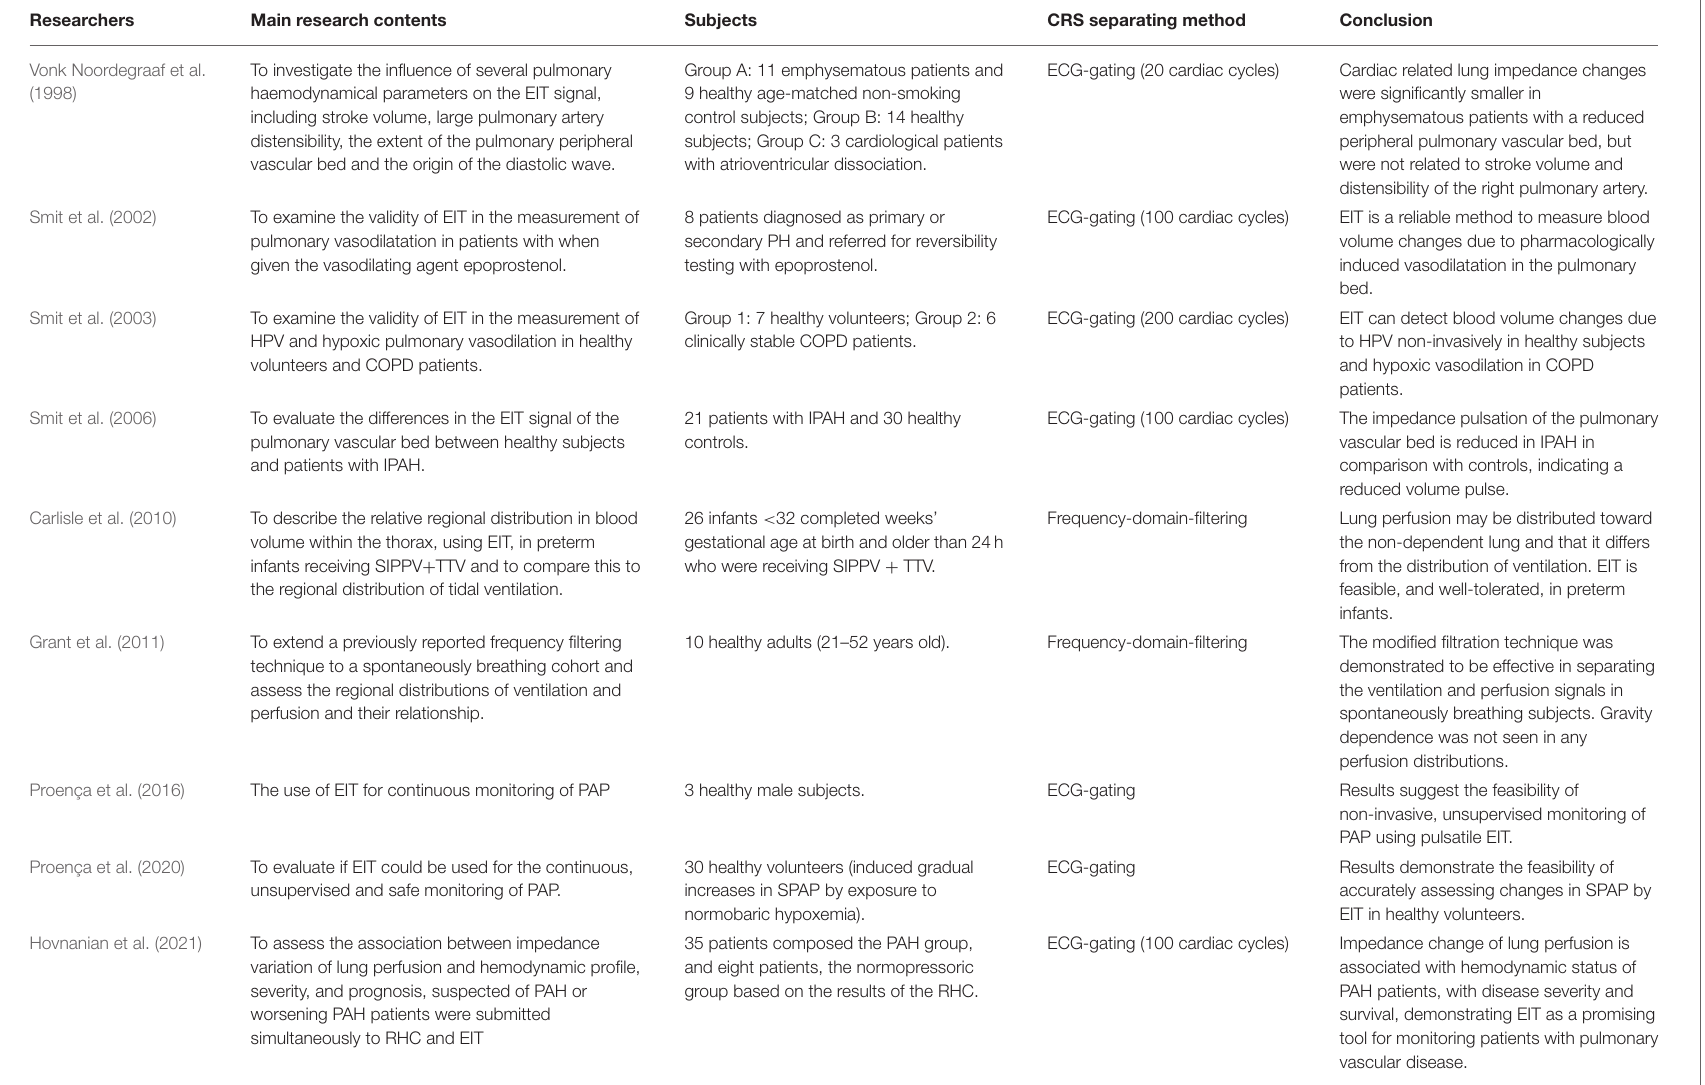
TABLE 1 | Summary on pulsatility-based EIT in clinical